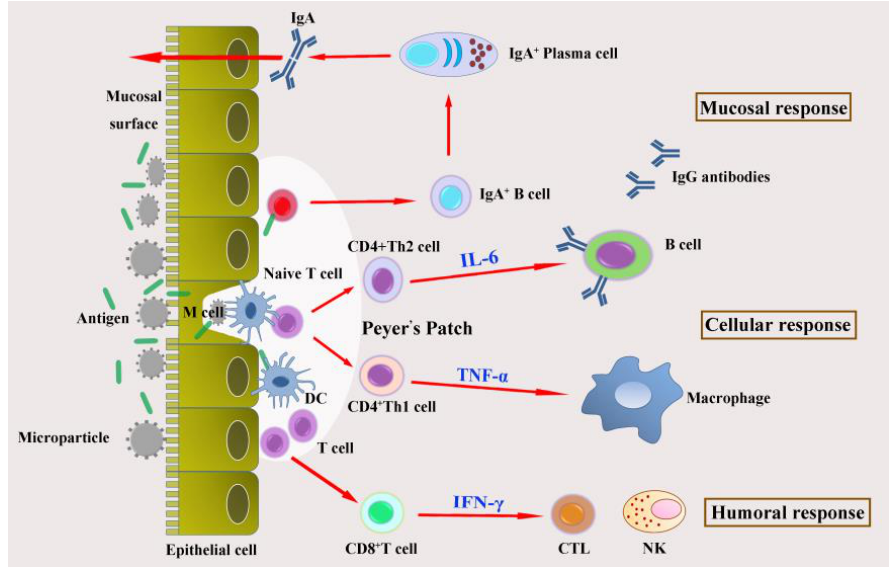
Figure 6. Immunity causes antibody production to be immune.